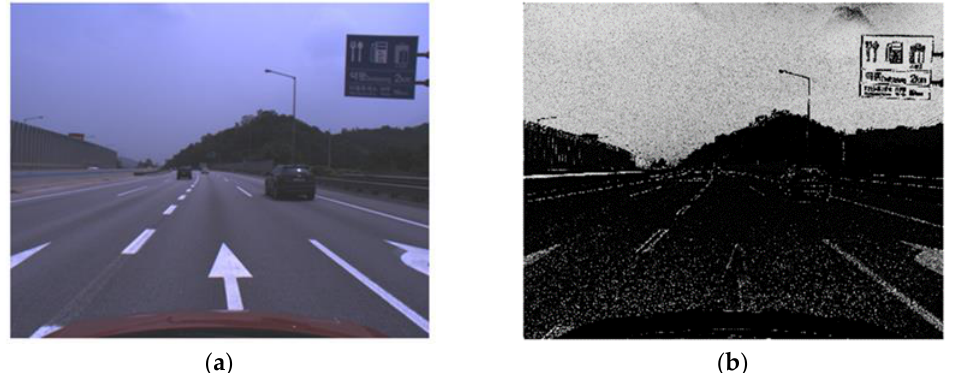
Figure 1. Traffic signs in Korea [31].